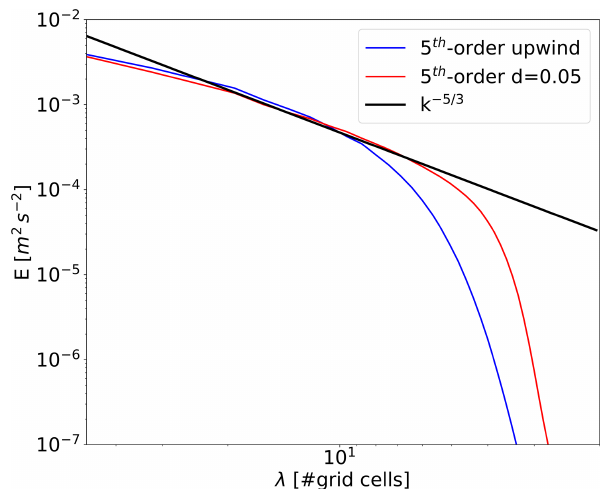
Figure A1. Developed energy-spectra in the flow-parallel direction for simulations of decaying isotropic turbulence with a superim- posed translation velocity of similar magnitude to the turbulent fluc- tuations. The energy spectra are influenced by both the diffusive and dispersive errors of the advection